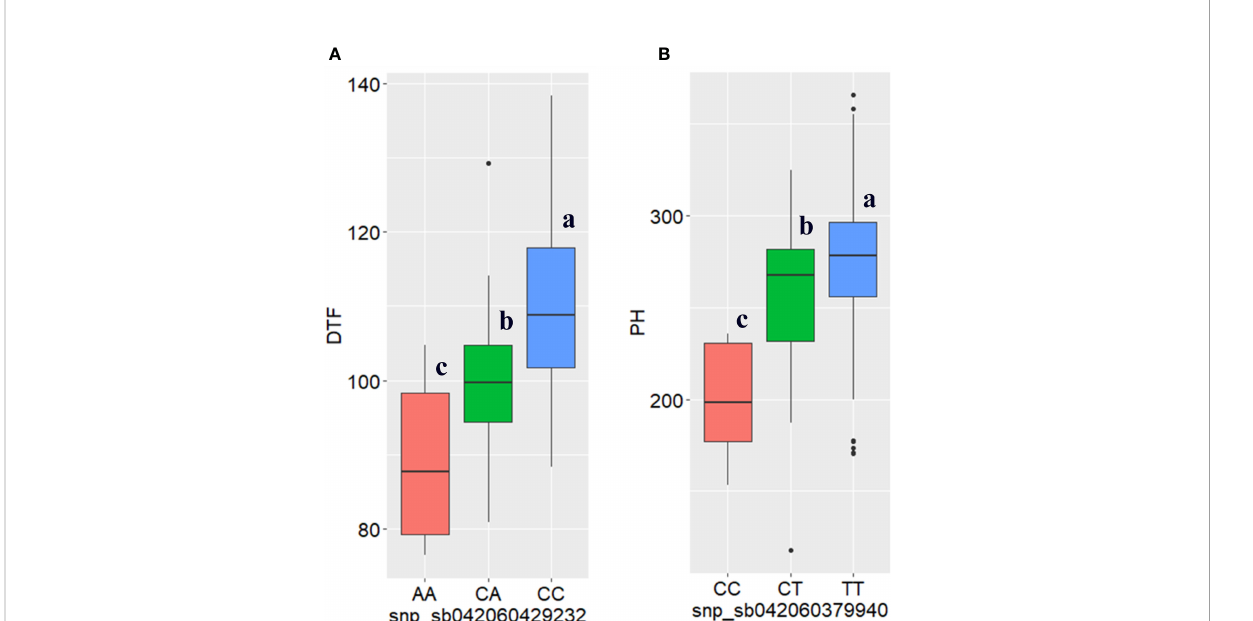
FIGURE 6 Boxplots of high signal SNPs (sbi10438246 and sbi7769289) showing the effects of their alleles on (A) days to fl owering (DTF) and (B) plant height (PH), respectively, generated based on the best linear unbiased predictor analysis of the combined phenotypic data from the three locations. Statistical signi fi cance for differences between alleles in the 309 sorghum genotypes was determined using the Tukey ’ s HSD (honestly signi fi cant difference) test. The different letters in the box plot indicates the signi fi cance difference among the mean P < 5%